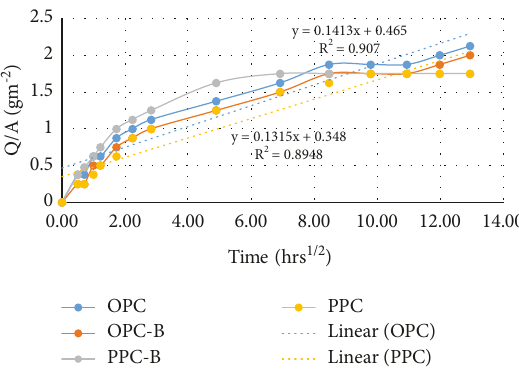
Figure 7: Cumulative water absorption (Q/A) for control cement Table 5: Sorptivity coefficient ( k ) of OPC and PPC samples derived from the graphical illustration. Cement sample